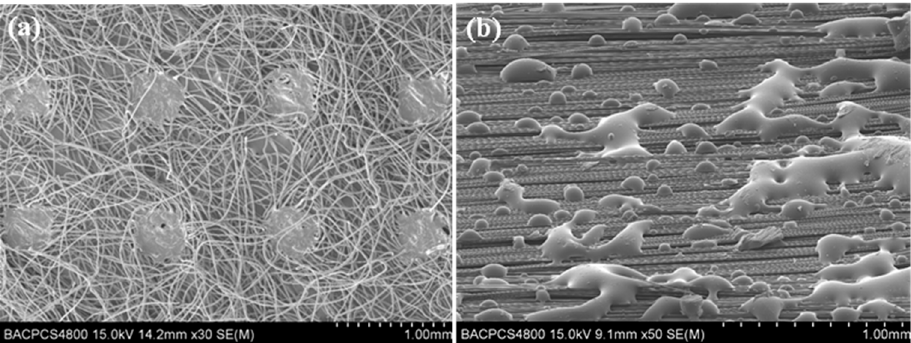
Figure 4. SEM images of toughening agents: ( a ) nonwoven fabric; ( b ) fabric with dot matrix structure.